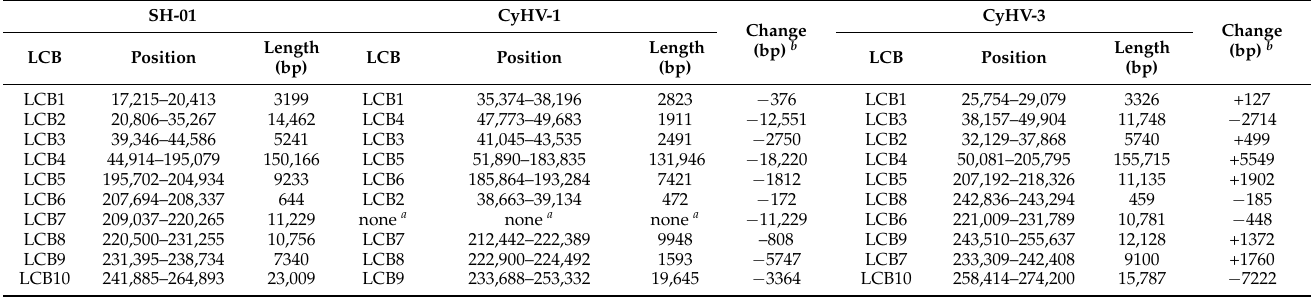
Table 2. Comparison of LCBs among the SH-01, CyHV-1, and CyHV-3